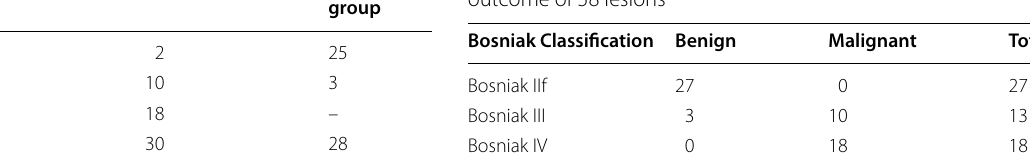
Table 2 Analysis of surgical and non‑surgical groups in 58 studied cysts Bosniak classification Surgical Group Nonsurgical